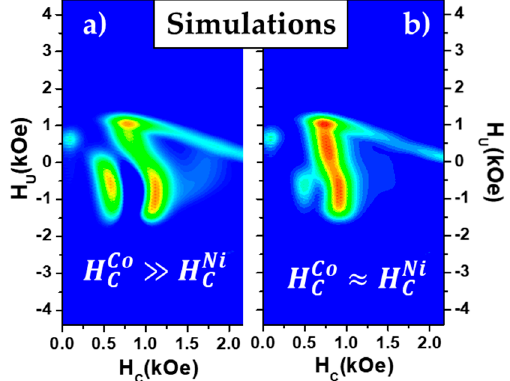
Figure 9. Simulated FORC diagrams of a coupled Ni/Co bisegmented nanowire array for the cases where the switching field of Co is much greater a) or slightly larger b) than the Ni switching field.